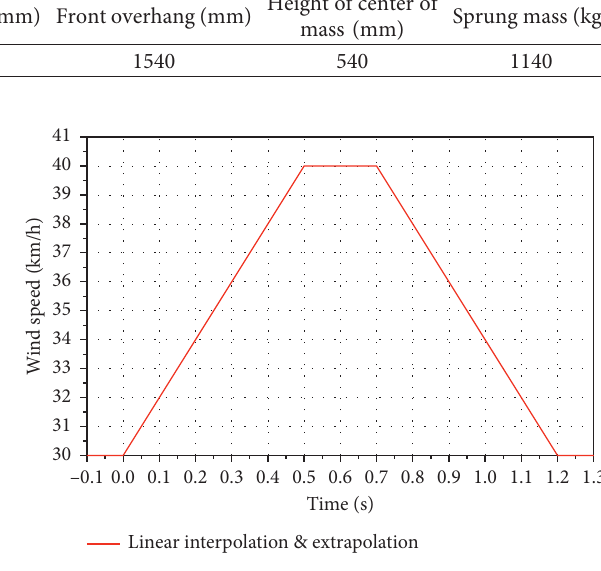
Figure 6: Wind speed data setting